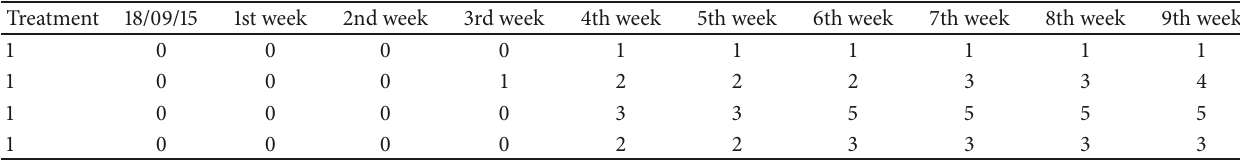
Figure 1: Light microscopy observations of Sub1 cultures. The coccobacillus cell shapes are pointed by blue boxes (above). Note: the image has been edited to sharpen the cell contours and is not a reflection upon Gram staining. Table 3: The week by week changes in nodule number, in Sub1 treated hydroponic